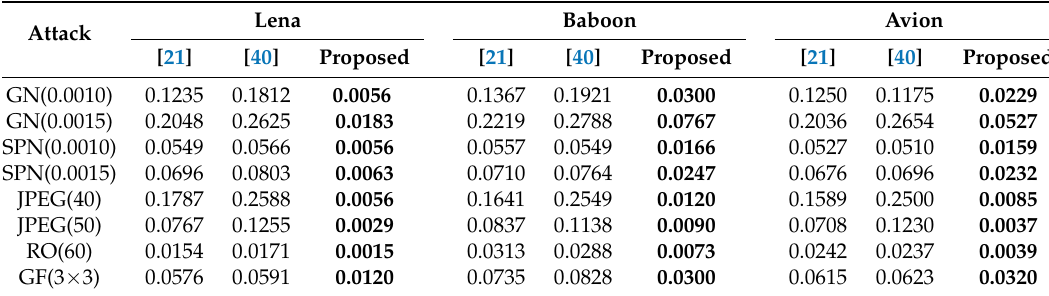
Table 1. BER comparison with PSNR = 42 dB under different image attacks.